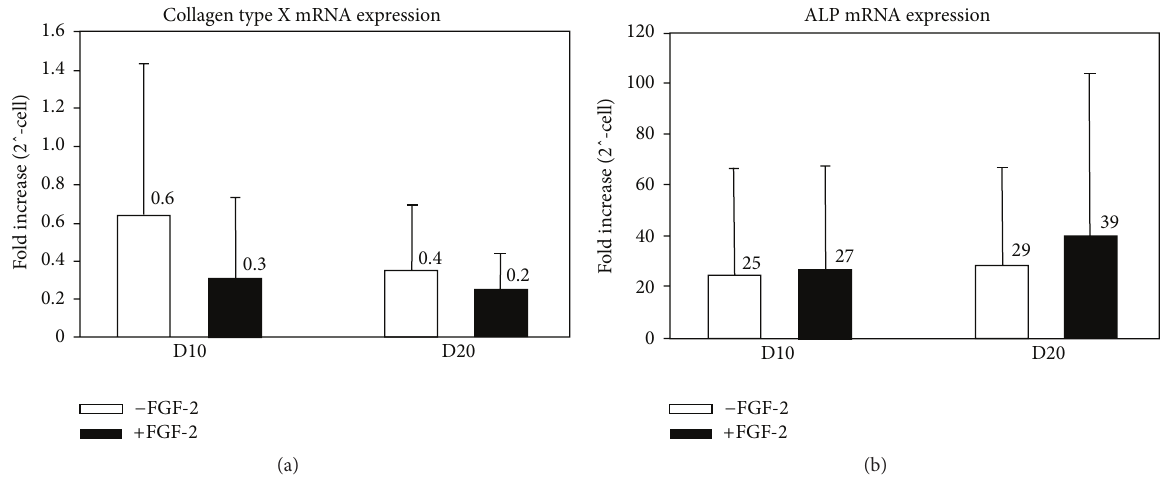
Figure 6: Collagen type X (a) and ALP (b) mRNA expression (fold increase) on days 10 and 20 of chondrogenic culture with (white) or without (black) FGF-2 supplementation ( 𝑛 = 3 ;